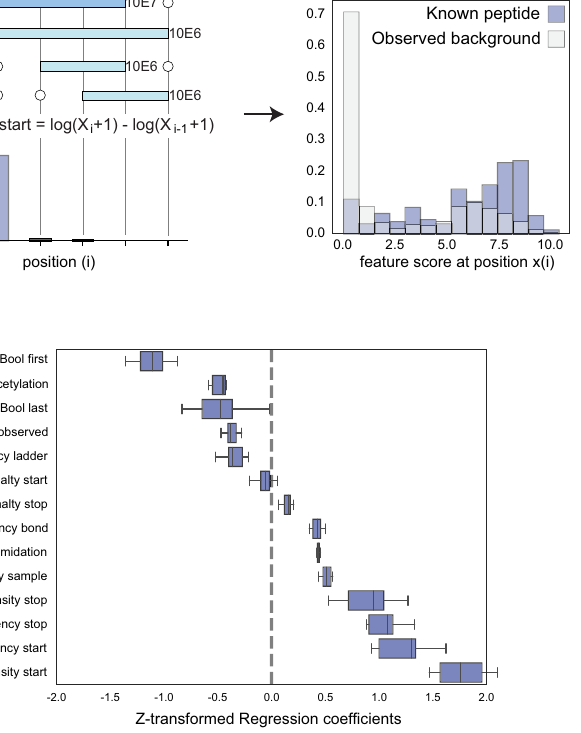
Fig. 4 | Computational identi fi cation of potential bioactive peptides. a Illustration of feature encoding and distribution (using the feature “ Intensity start ” as example) and PPV model design (Supplementary Note 1). In the feature distribution plot, the group of knownannotated peptidesis shown asbluebars, all other observed peptides as white bars and the overlap between the two in light blue. b Box plot showing the model regression coef fi cients (weights) in the fi nal model. Each box-plot shows the coef fi cients across the 20 models from 5-fold nested cross-validation. The box plot centre line is the median, the bounds are the lower (25th percentile) and upper (75th percentile) quartile values. The lower whiskerextendstothelowestobservedvaluegreaterthanthelowerquartileminus